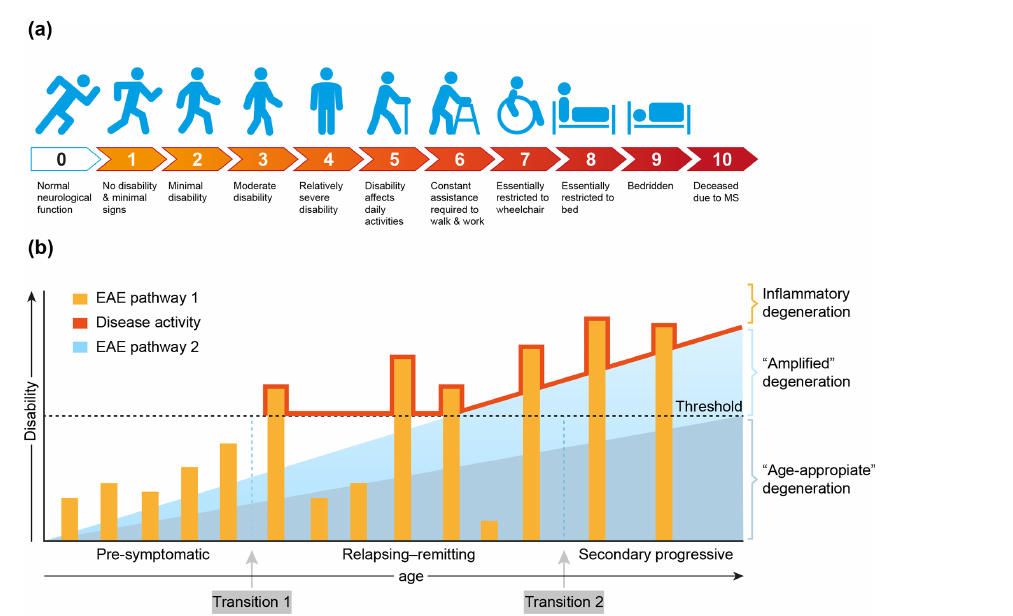
Figure 4. Clinical aspects of multiple sclerosis. (a) For quantification of the degree of disability, for example in the clinical assessment of new treatments, the expanded disability status scale (EDSS) has been developed (Kurtzke, 1983). (b) A graphical representation of the most common MS phenotype. In the beginning MS is asymptomatic, but with advanced imaging techniques (contrast-enhanced MRI for example) focal abnormalities due to inflammation can be observed inside the brain white matter. This is followed by a period of variable length between patients where the inflammation increases in severity causing discrete episodes of disability (relapse) alternating with com- plete recovery (remission). In about 50% of the patients with relapsing–remitting MS the disease becomes progressive, where remissions disappear and neurological functions decrease progressively. Based on data from the marmoset EAE model, we posit that the degeneration of oligodendrocyte/myelin complexes can be differentiated into three types: (1) normal age-appropriate progressive degeneration; (2) pro- gressive degeneration amplified by a newly discovered T cell attack on oligodendrocytes; (3) reversible degeneration induced by a classical autoimmune attack of pro-inflammatory T cells and autoantibodies on myelin